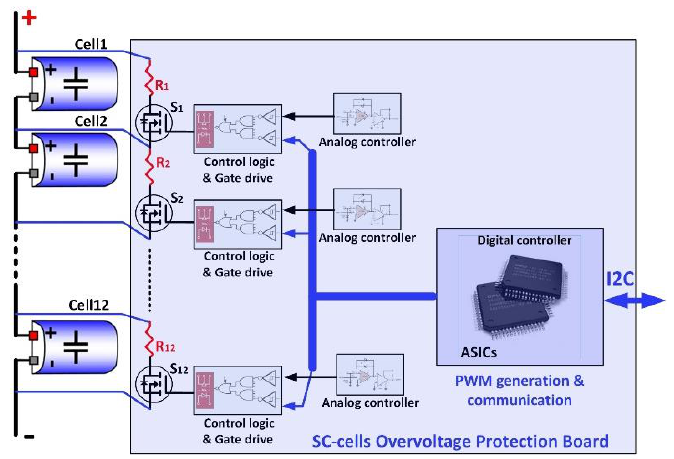
Figure 4. Block diagram represents the design of the SC cells’ overvoltage protection within a single module as apart of the full overvoltage protection subsystem of the SC-ESS. The subsystem consists of a shunt circuit per cell, formed by a semiconductor switch (Si) and a power resistor (Ri), which is controlled by two independent controllers: the first